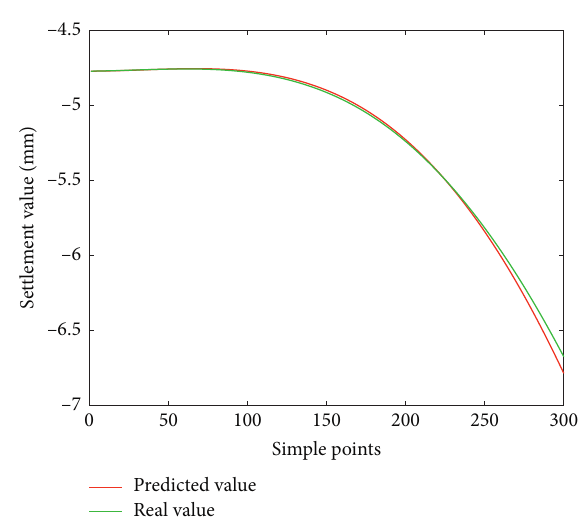
Figure 10: Trend term prediction result.